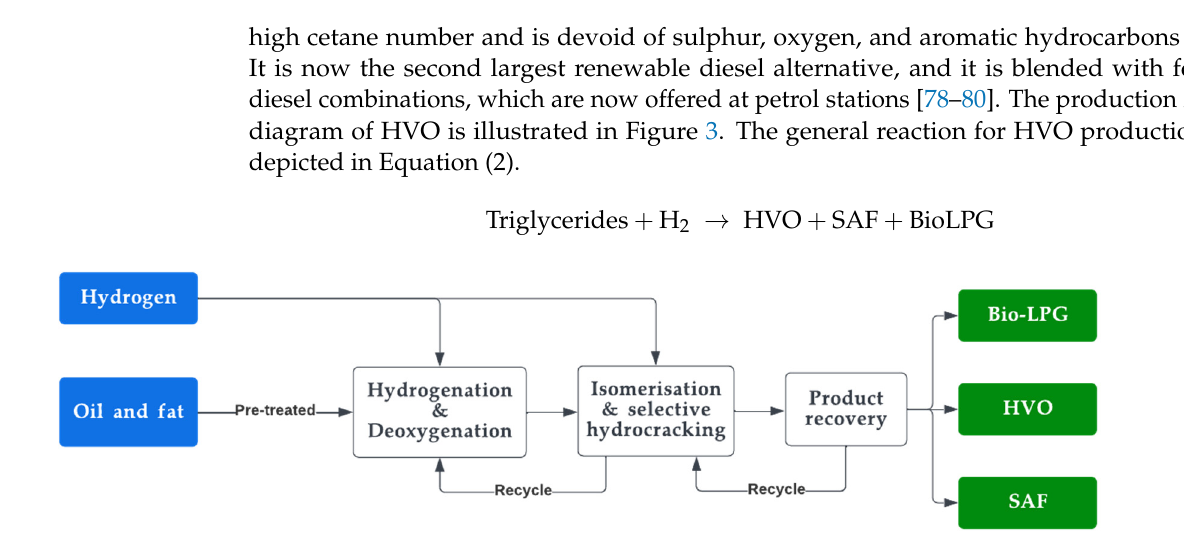
Figure 3. HVO production